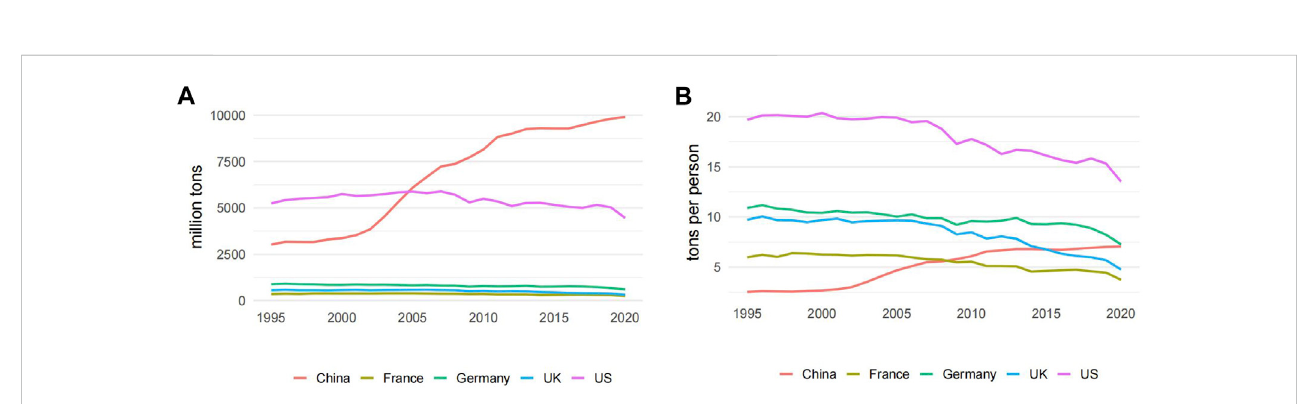
FIGURE 2 Comparison of countries ’ carbon emissions from 1995 to 2020 (A) . Comparison of total carbon emissions; (B) . Comparison of carbon emissions per capita